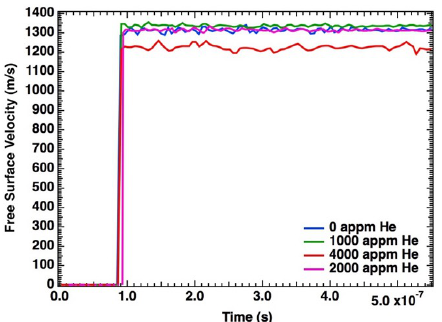
Figure 8. Velocity–time history from one of the flat regions for each of the four